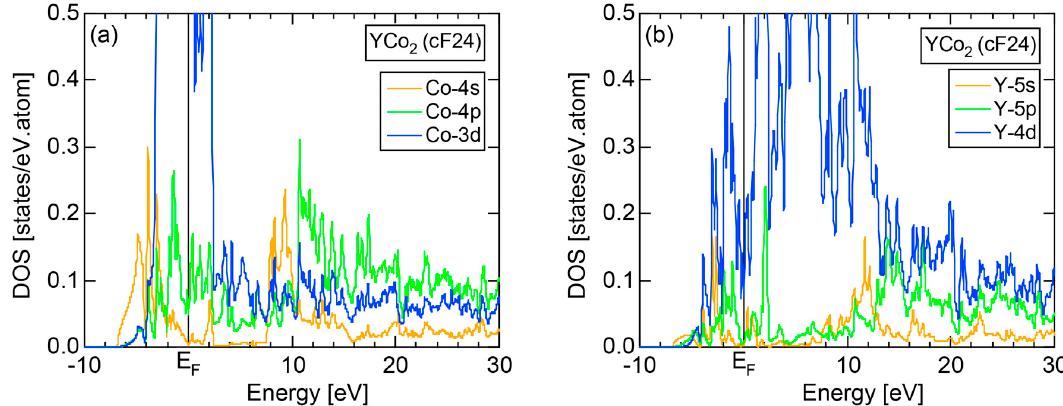
Figure 101. ( a ) Co- and ( b ) Y-partial DOSs for Laves compound YCo 2 (cF24) [37].